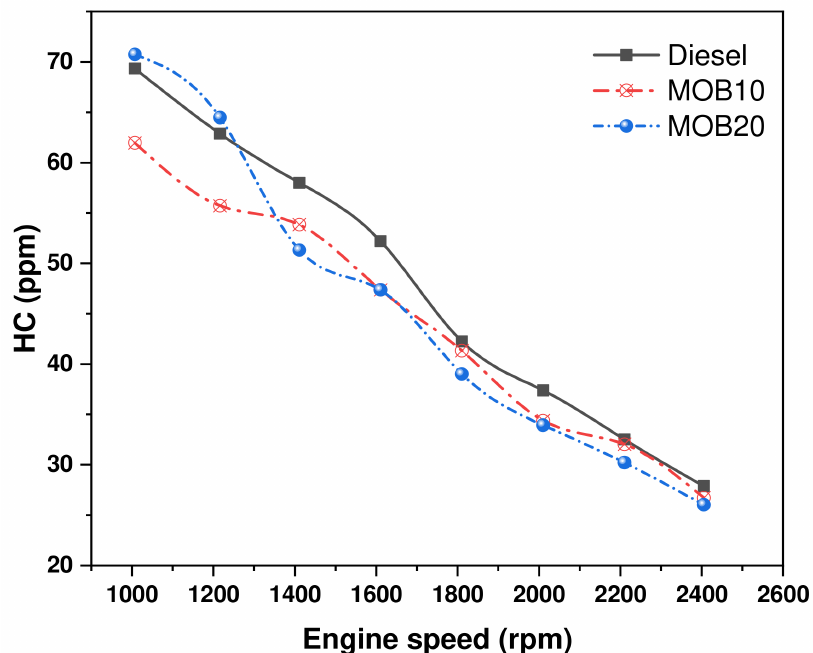
Figure 5. Unburned hydrocarbon emissions of Moringa oleifera biodiesel blends and diesel at varying engine